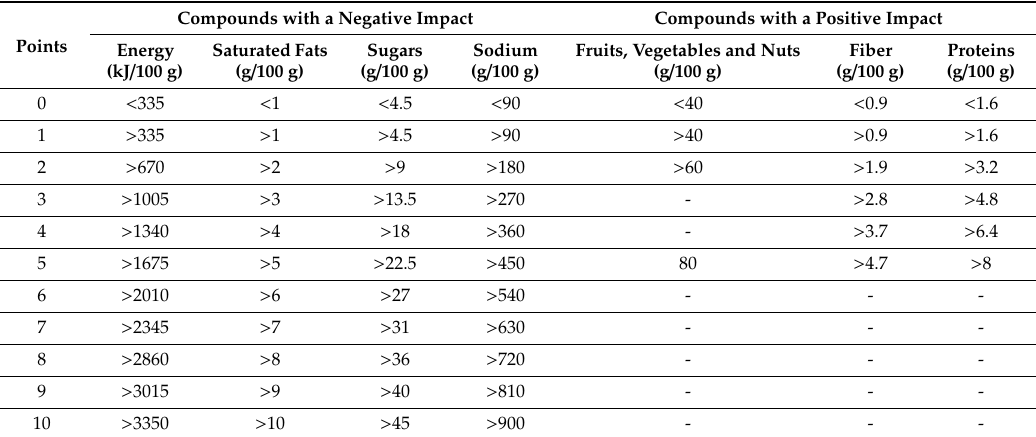
Table 1. Calculation algorithm for the final score [52].